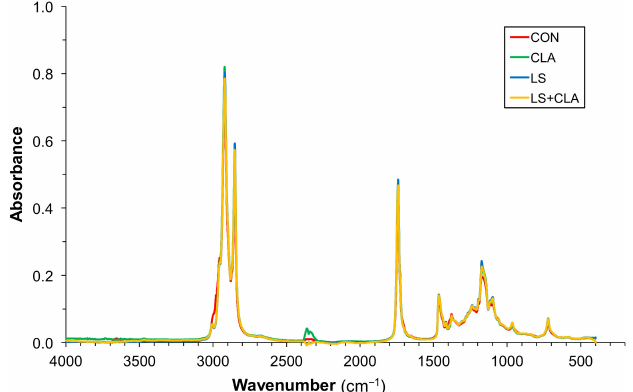
Figure 3. Mean absorbance spectra of 96 fat samples according to the four dietary treatments: CON = control; LS = 10% linseed; CLA = 2% conjugated linoleic acid;